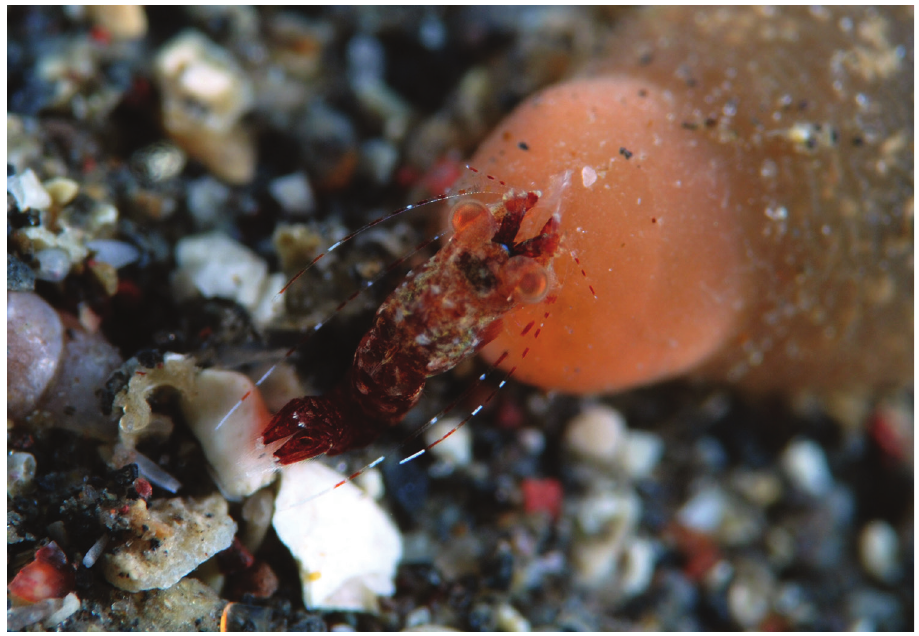
Figure 1. Mysidella hoshinoi sp. n., sex unknown, on a tentacle of a sea anemone (family Haloclavi- dae), Akino-hama, Izu-Oshima Island, Sagami Sea, Japan, 25 March 2016, 35 m depth, habitus in situ , photographed by O.